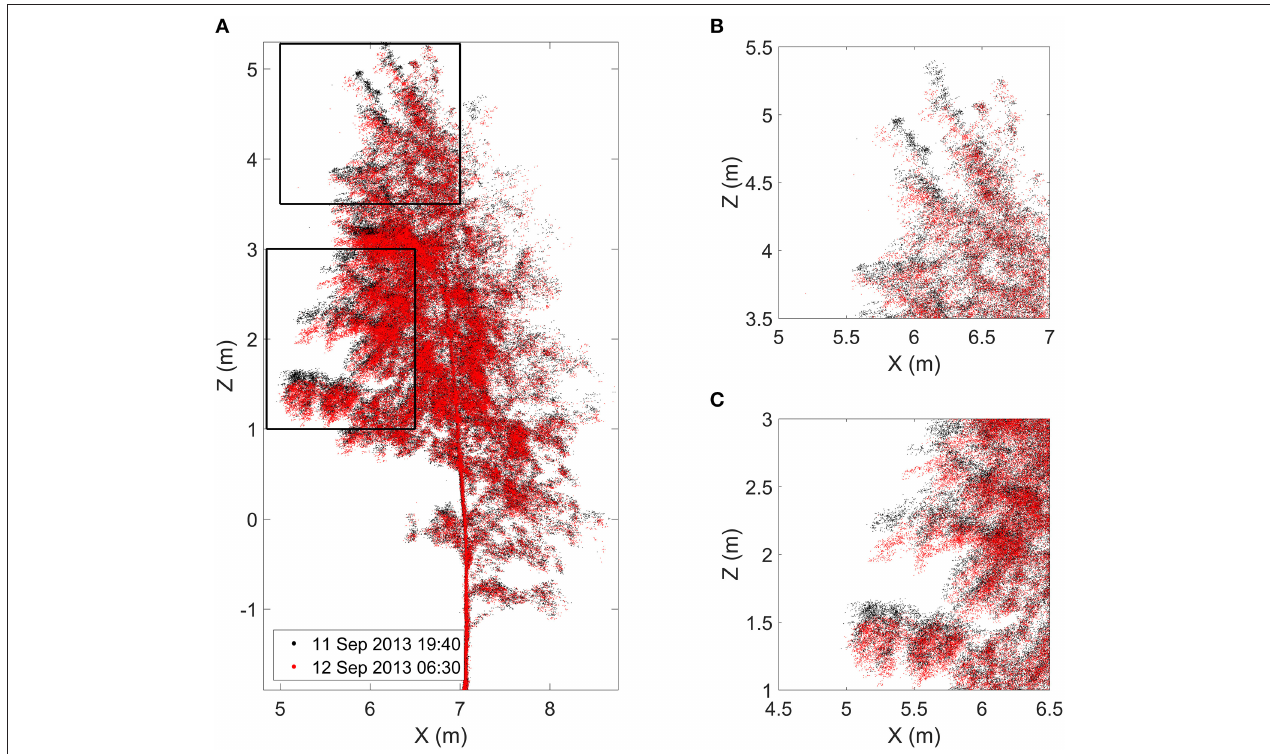
FIGURE 4 | (A) Finnish birch point cloud profiles at the time of sunset (black) and at the time of the maximum movement around 06:40 o’clock (red). Black frames mark zoomed in boxes in the upper (B) and in the lower (C) crown. Video 1 visualizes the geometrical change in the Finnish birch point cloud over night. It is provided in the Supplementary